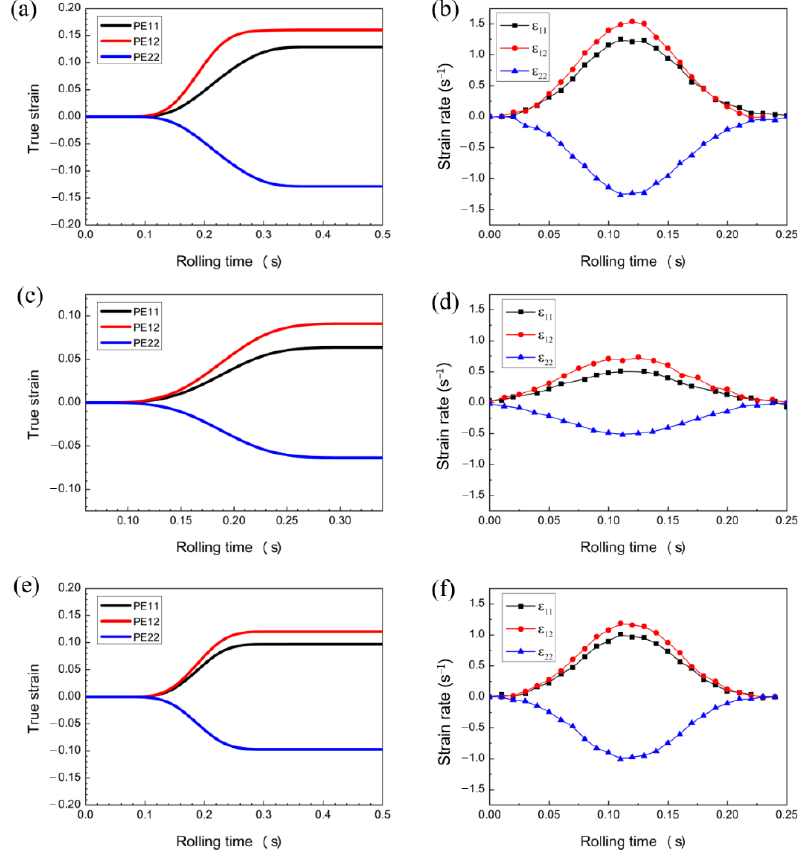
Figure 5. Evolution of equivalent stress field and strain rate in the center of sample plate by asym- metric rolling: changes in the ( a ) 1.5 mm stress field, ( b ) 1.5 mm strain rate, ( c ) 0.75 mm stress field, ( d ) 0.75 mm strain rate, ( e ) 0.5 mm stress field, and ( f ) 0.5 mm strain rate.